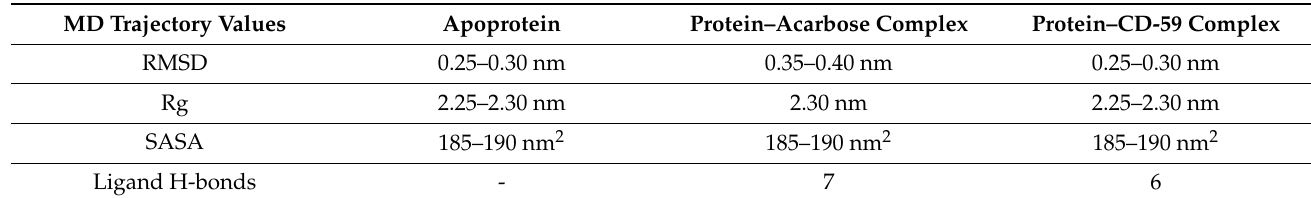
Table 4. MD trajectory values obtained for CD-59 and acarbose complexed with α